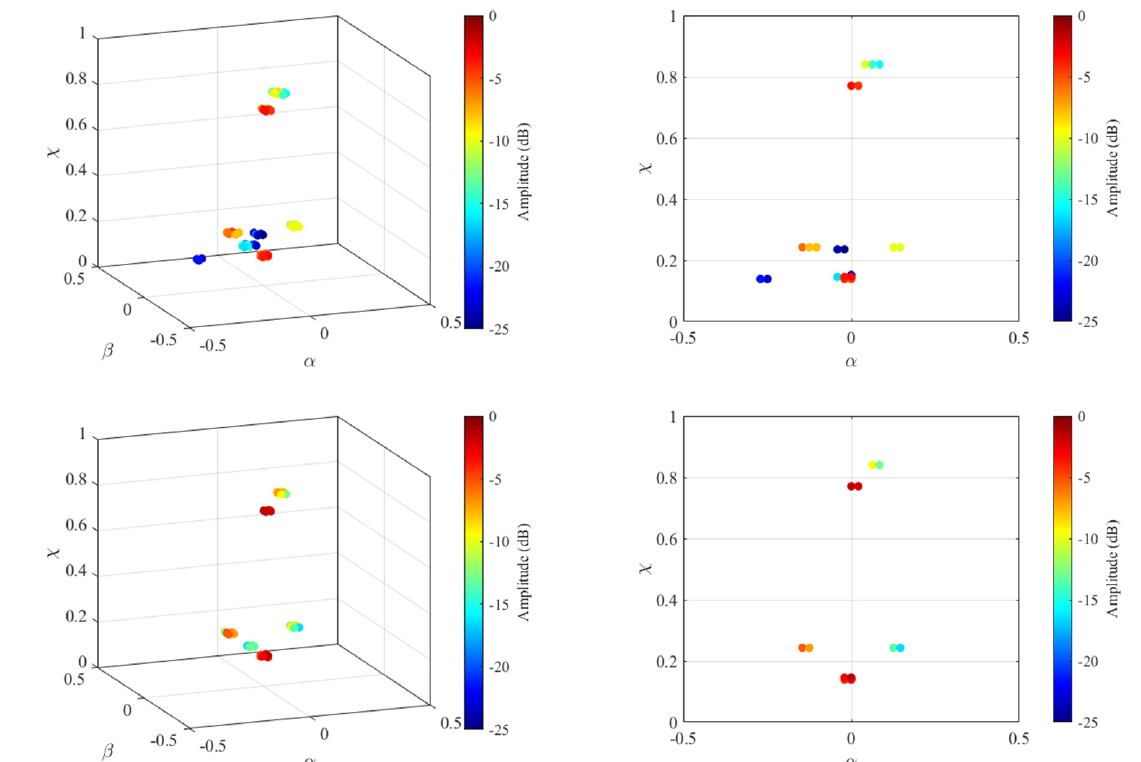
Figure 34. Real target imaging results obtained by the TSL0 algorithm with (top) random sparse-sampled signal cube and (bottom) cognitive sparse-sampled signal cube.